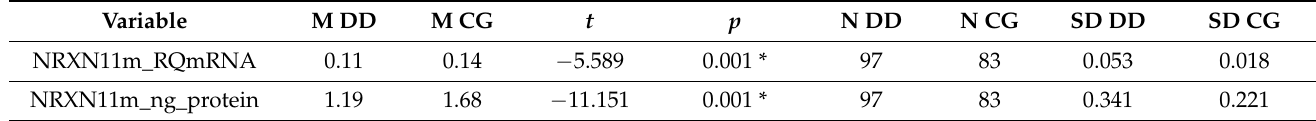
Table 2. Expression of the NRXN1 gene in the examined